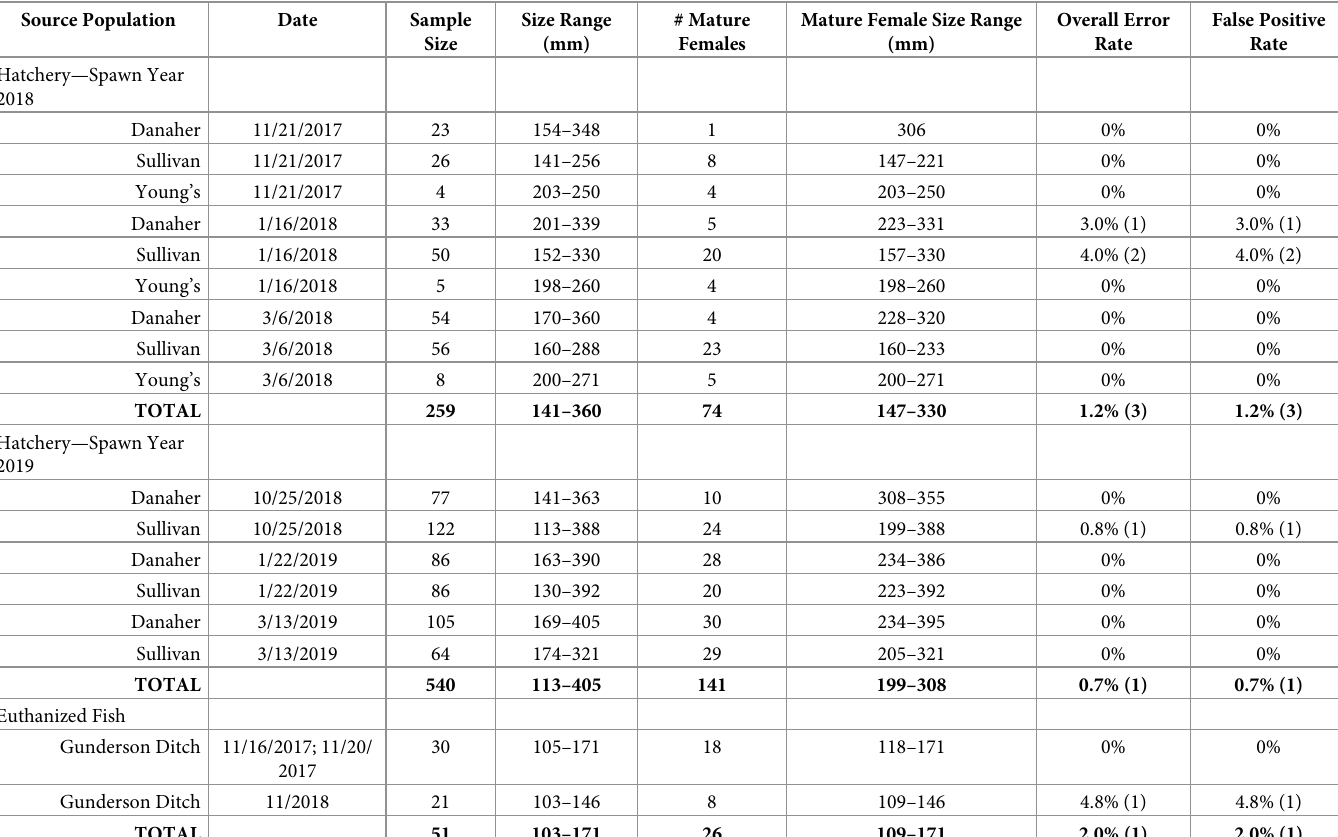
Table 1. Accuracy of ultrasound examinations for identifying mature female Westslope Cutthroat Trout in resident populations from western Montana. Source